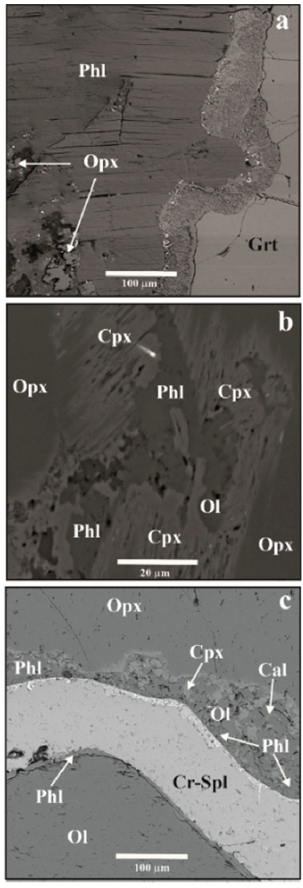
Figure 1. Phlogopite-bearing reaction textures in the metasomatized peridotite xenoliths in kimberlites of the Udachnaya pipe, Yakutia. ( a ) Wide phlogopite corona containing relics of orthopyroxene around garnet from the garnet peridotite; later keliphite zone is developed between phlogopite and garnet relic. ( b ) Reaction zone composed of phlogopite, clinopyroxene, olivine and calcite at the contacts of orthopyroxene and Cr-spinel from the spinel harzburgite. ( c ) The reaction zone of “spongy” clinopyroxene, phlogopite and olivine developed on orthopyroxene in garnet lherzolite (photo courtesy of I. Sharygin, Institute of the Earth’s Crust, Siberian Branch of RAS, Irkutsk). All mineral abbreviations are from [48].